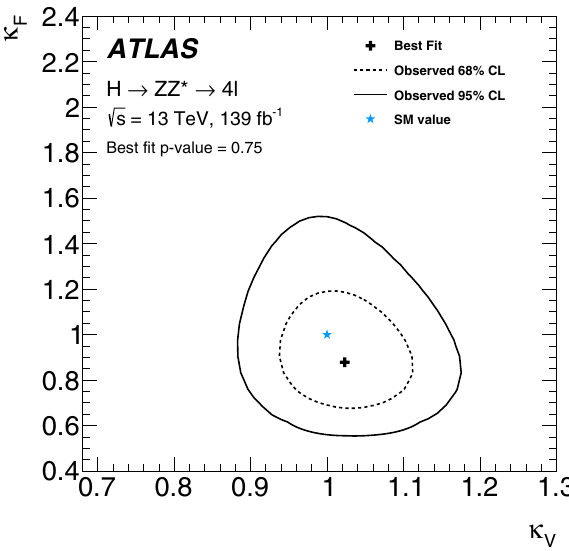
Fig. 12 Likelihood contours at 68% CL (dashed line) and 95% CL (solid line) in the κ V – κ F plane. The best fit to the data (solid cross) and the SM prediction (star) are also indicated even) parameters vanish. The dependence of the acceptance on other EFT coupling parameters is shown to be negli- gible as these parameters have negligible or no impact on the H → Z Z ∗ decay. The acceptance correction